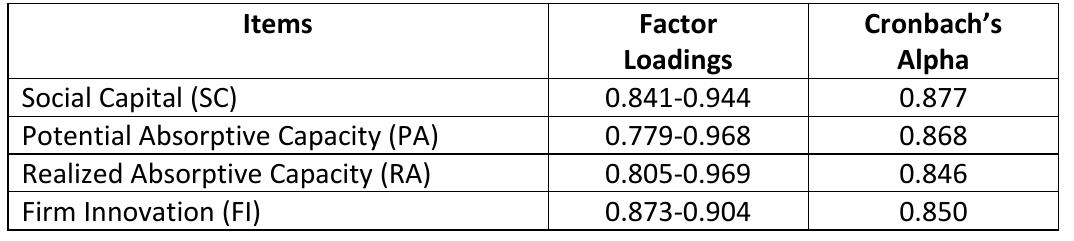
Table 1: Results of Measure